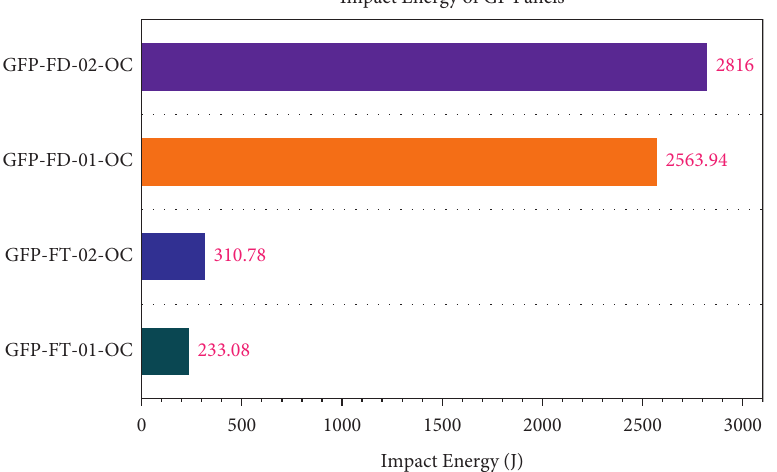
Figure 14: Energy absorption of GF panels under impact